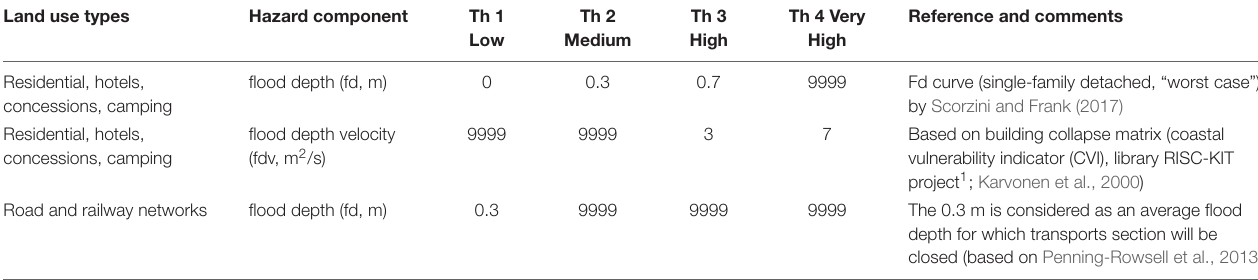
TABLE 4 | Vulnerability indicators for the direct impact of flooding and corresponding